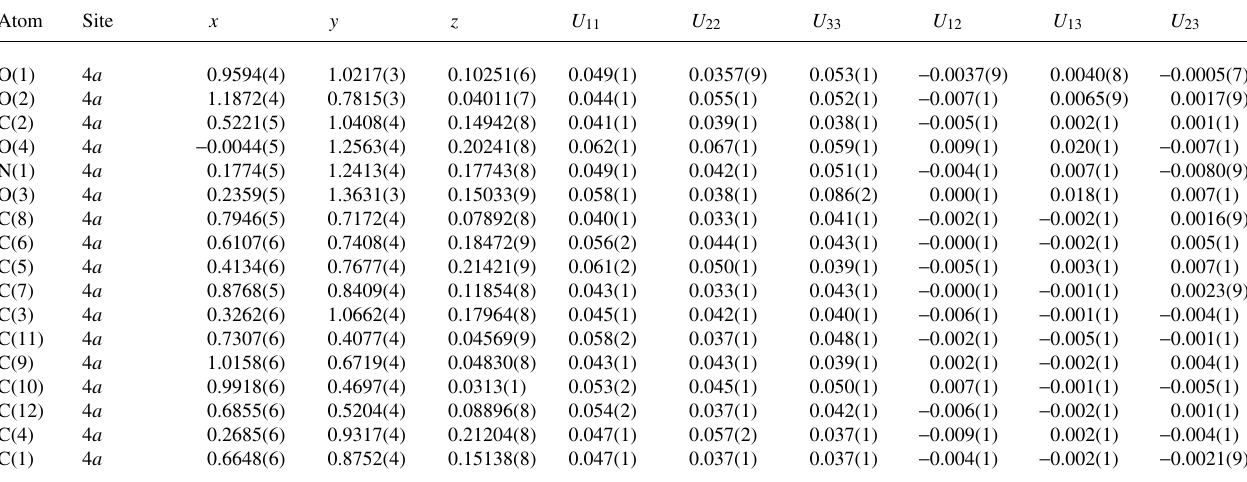
Table 3. Atomic coordinates and displacement parameters (in Å 2 )